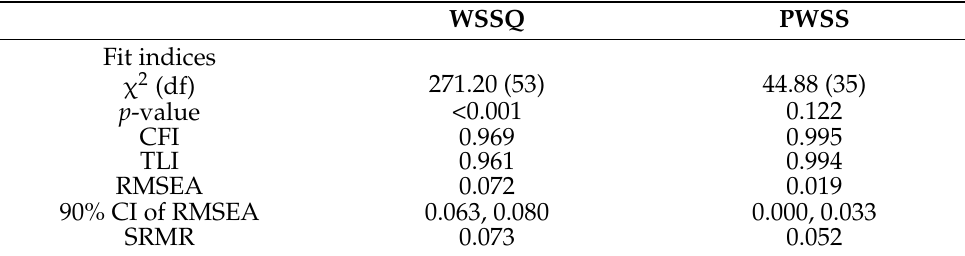
Table 2. The fit indices for the WSSQ and